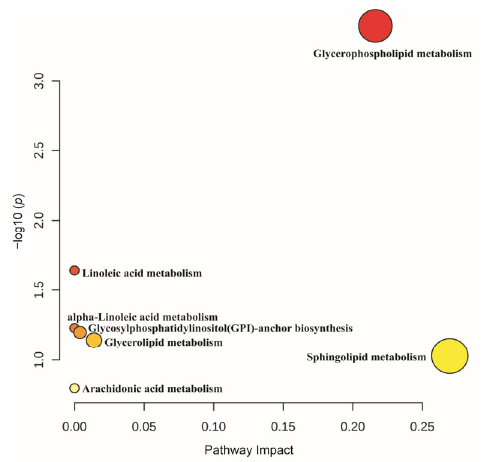
Figure 10. Pathway enrichment of all differently accumulated lipids identified by three groups.